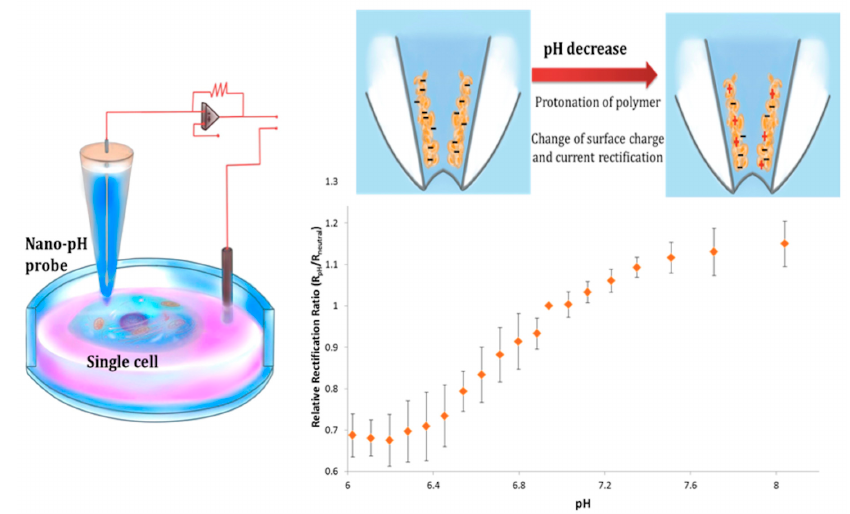
Figure 8. Schematic representation of electrochemical configuration and pH monitoring in a single cell with a chitosan-modified nanopipette. (Reproduced from [96] with the permission of the Royal Society of Chemistry).